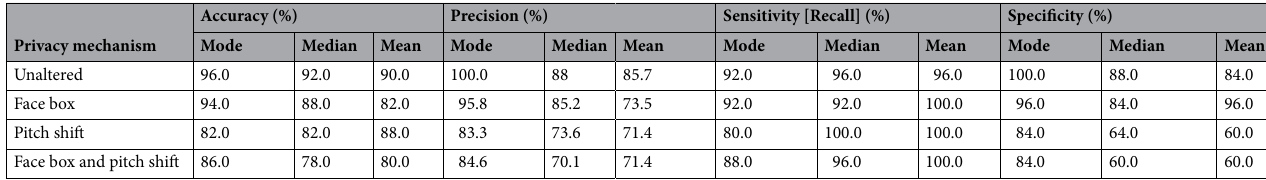
Table 2. Performance of the LR10 classifier on aggregated crowd features across privacy-preserving mechanisms when using the mode, median, and mean aggregation methods, respectively. Sensitivity of the classifier is retained even with the most stringent privacy-preserving mechanisms. A probability threshold of 0.5 was used to distinguish the ASD and neurotypical